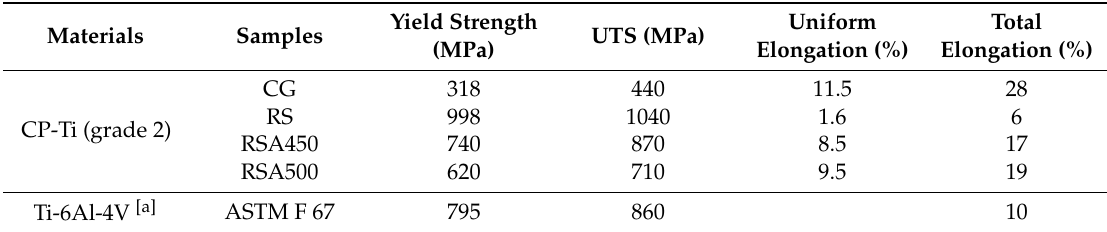
Table 1. Mechanical properties of present RS-processed samples and Ti-6Al-4V